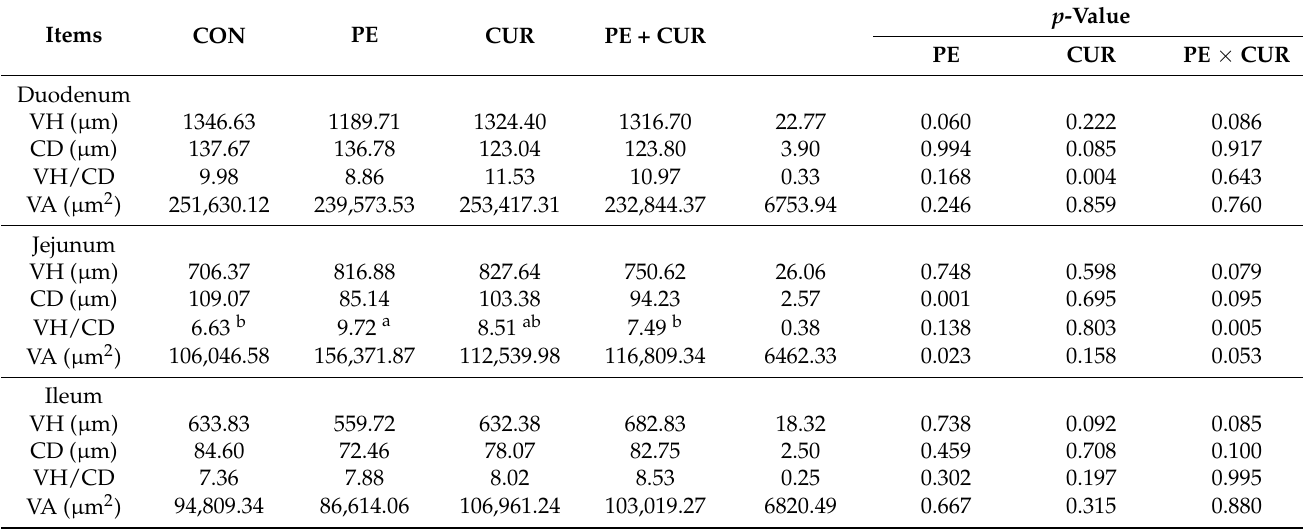
Table 6. Effects of dietary supplementation with PE and CUR on intestinal morphology of broilers 1 .